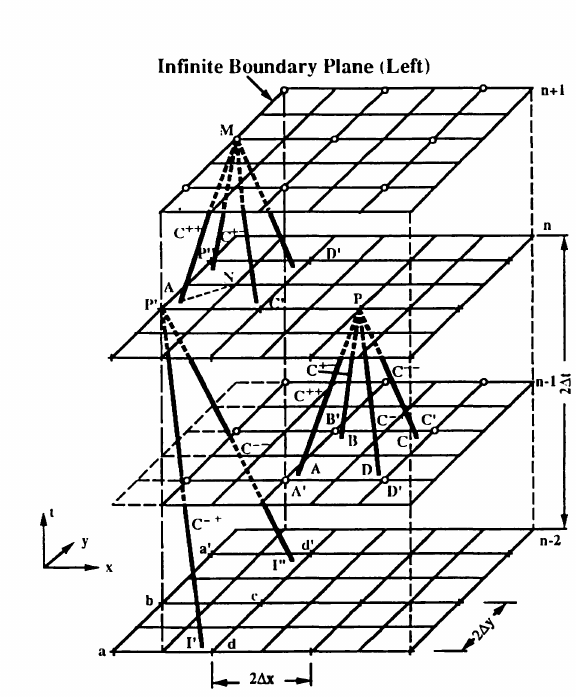
FIGURE 4 Characteristic projection (A) at infinite left